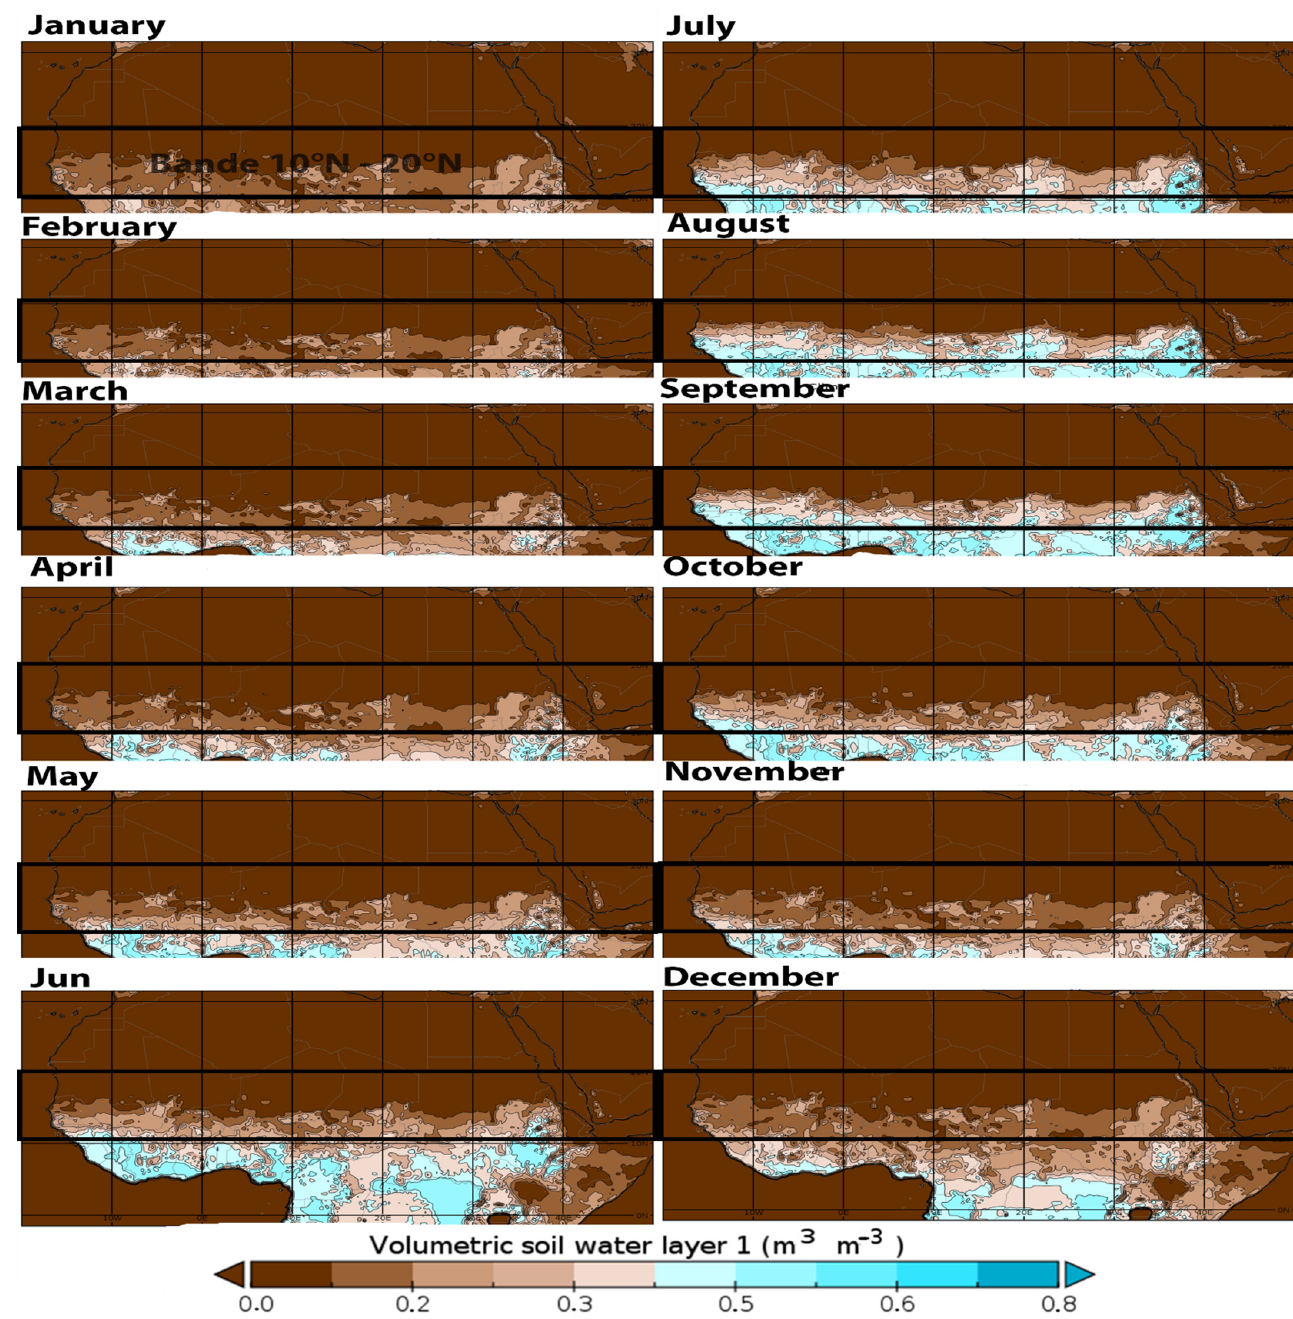
Figure 11. Climatology of the volumetric soil water level (4D-Var ERA5) in m 3 s − 3 , from 1979 to 2008 with a resolution of 0.5 × 0.5 degrees. Data from the ERA5 platform. Table 1. Volumetric properties of soil